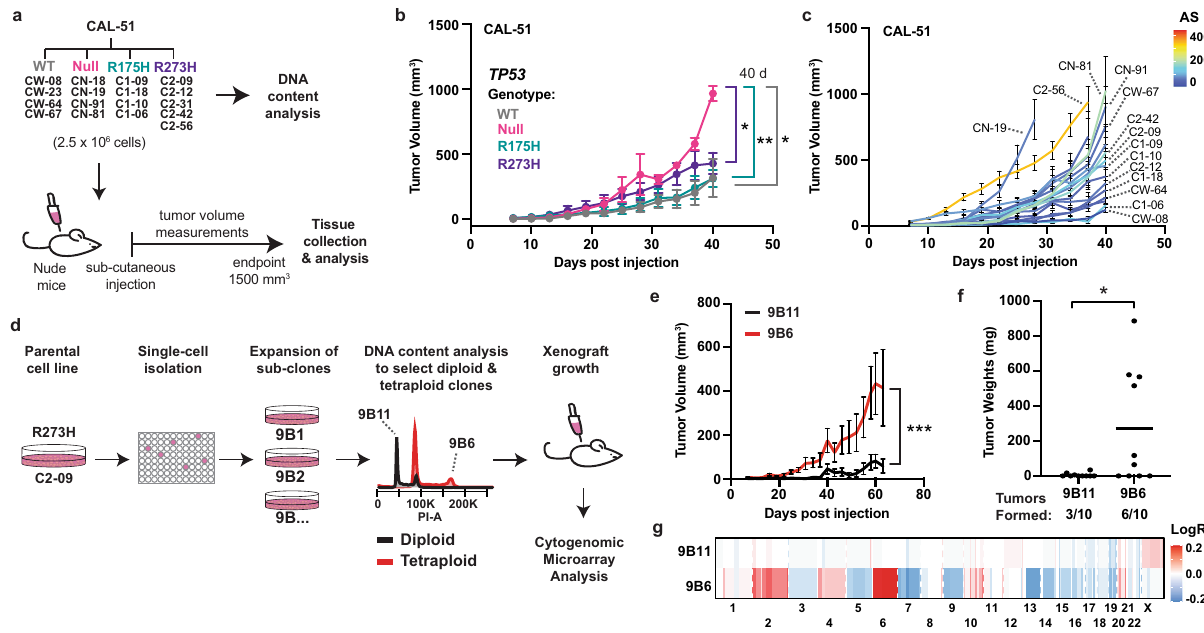
Fig. 5 Clonal differences in tumorigenicity are associated with aneuploidy and not mutant p53 expression. a Diagram demonstrating work fl ow for CAL- 51 xenograft tumor growth experiment. b , c Tumor volume (in cubic millimeters) of CAL-51 cell lines. Data shown represent the mean ± standard error of the mean (s.e.m.) tumor volume ( n = 10 tumors per cell line) measured across CAL-51 cell lines indicated in a averaged by b TP53 genotype or c colored by aneuploidy score (AS). d Diagram demonstrating work fl ow for single-cell isolation and subcutaneous xenograft experiment of CAL-51 diploid (9B11) and tetraploid (9B6) R273H mutant p53 subclones. e , f Tumor volume ( e ) and tumor weights ( f ) for 9B11 and 9B6 subclone xenografts. Data shown represent the mean ± s.e.m. tumor volume measured every three days ( n = 10 tumors per cell line). g Copy number alterations from cytogenomic microarray analyses in 9B11 and 9B6 subclones (Log 2 ratios, LogR). Chromosomal gain (red) and loss (blue). Signi fi cance tested using b mixed-effects analysis with Dunnett ’ s multiple comparison test, e , f Two-tailed Student ’ s t -tests. * P < 0.05, ** P < 0.01, *** P < 0.001. Source data and exact P values are provided in the Source Data tumor weight ( P = 0.019, Fig. 5f) compared to the diploid clone 9B11. Analysis of tumor DNA through CMA revealed the 9B6 clone was highly aneuploid compared to clone 9B11 (Fig. 5g). In